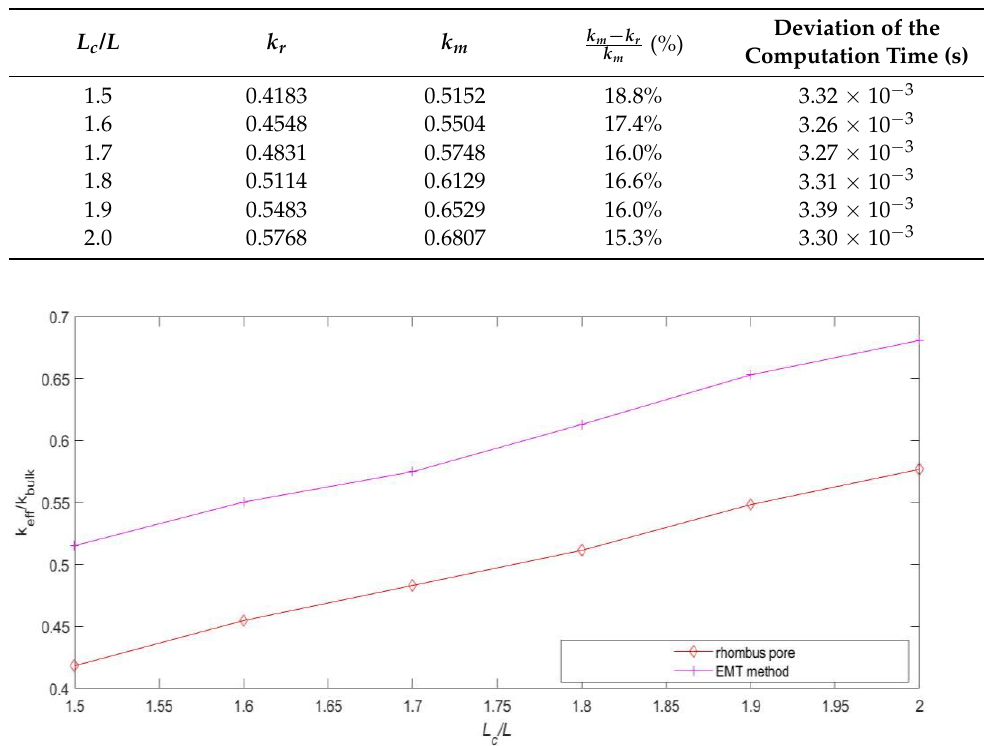
rhombus pores with changes of L c / L .